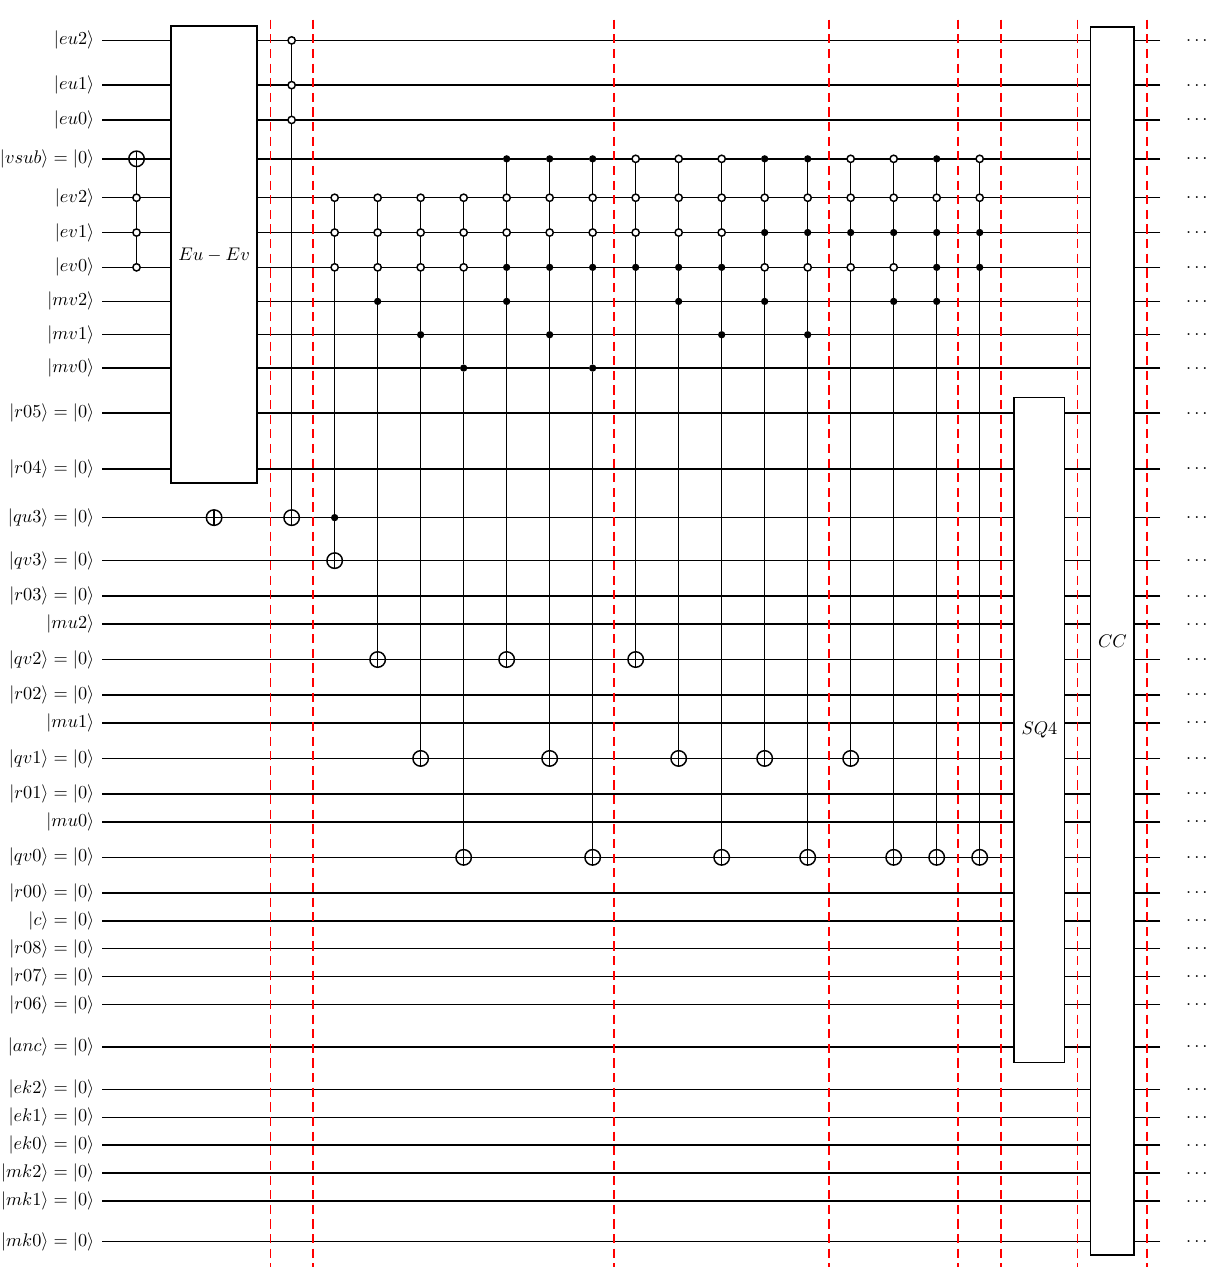
qubit mantissa squaring output −